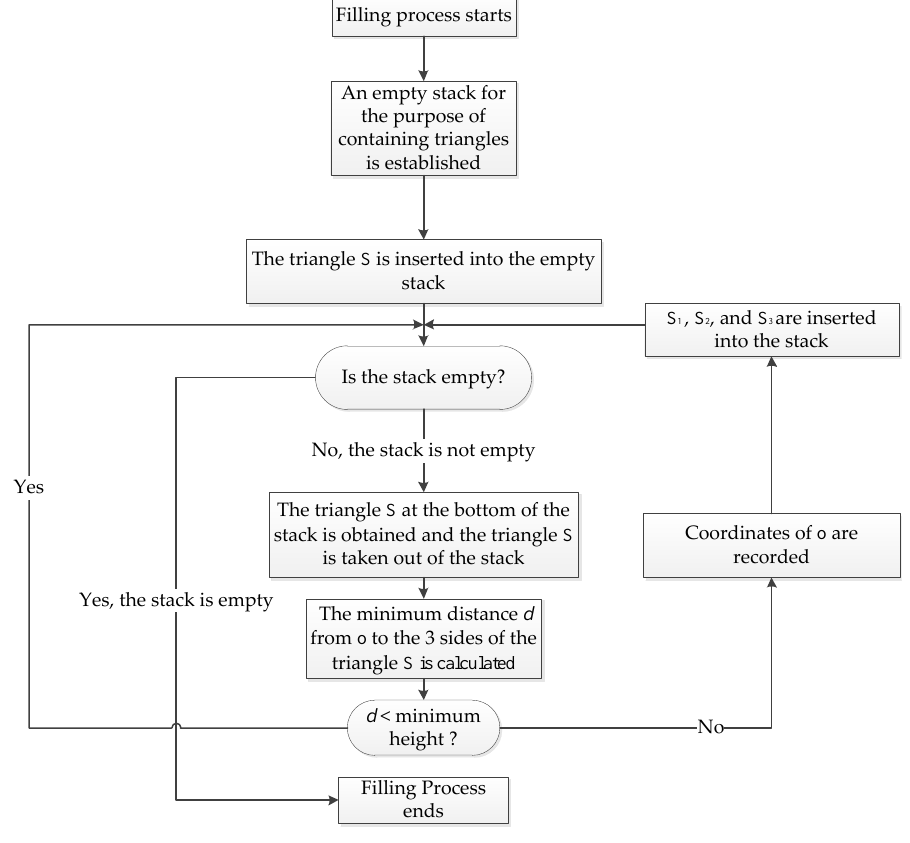
Figure 3. The filling process of the DFS algorithm.